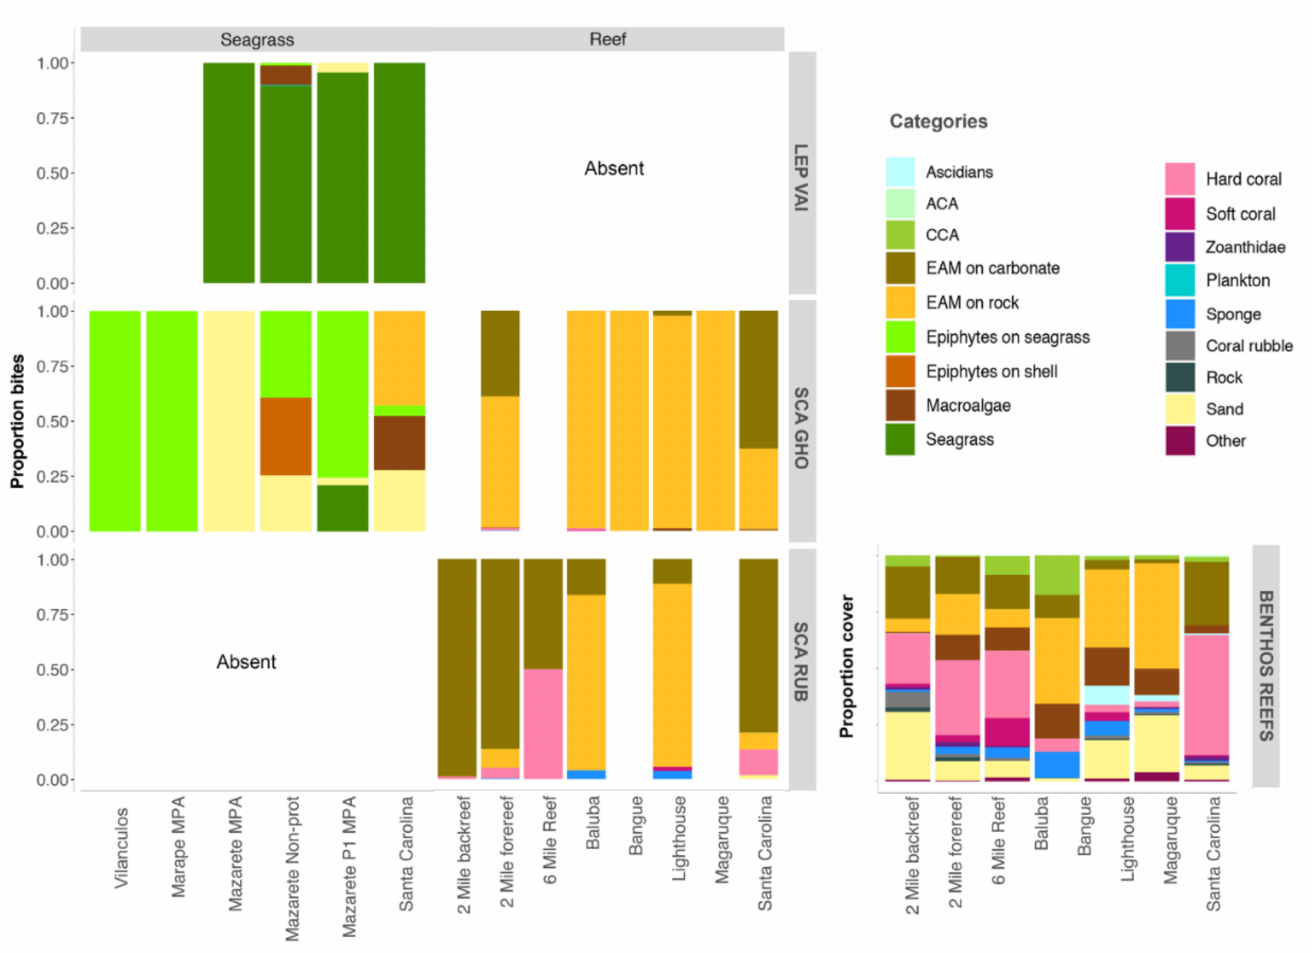
Figure A5. Proportion observed bite substrates of L. vaigiensis , S. ghobban and S. rubroviolaceus on reefs and in seagrass meadows on all survey sites. “Mazarete non- prot” corresponds to non-protected seagrass